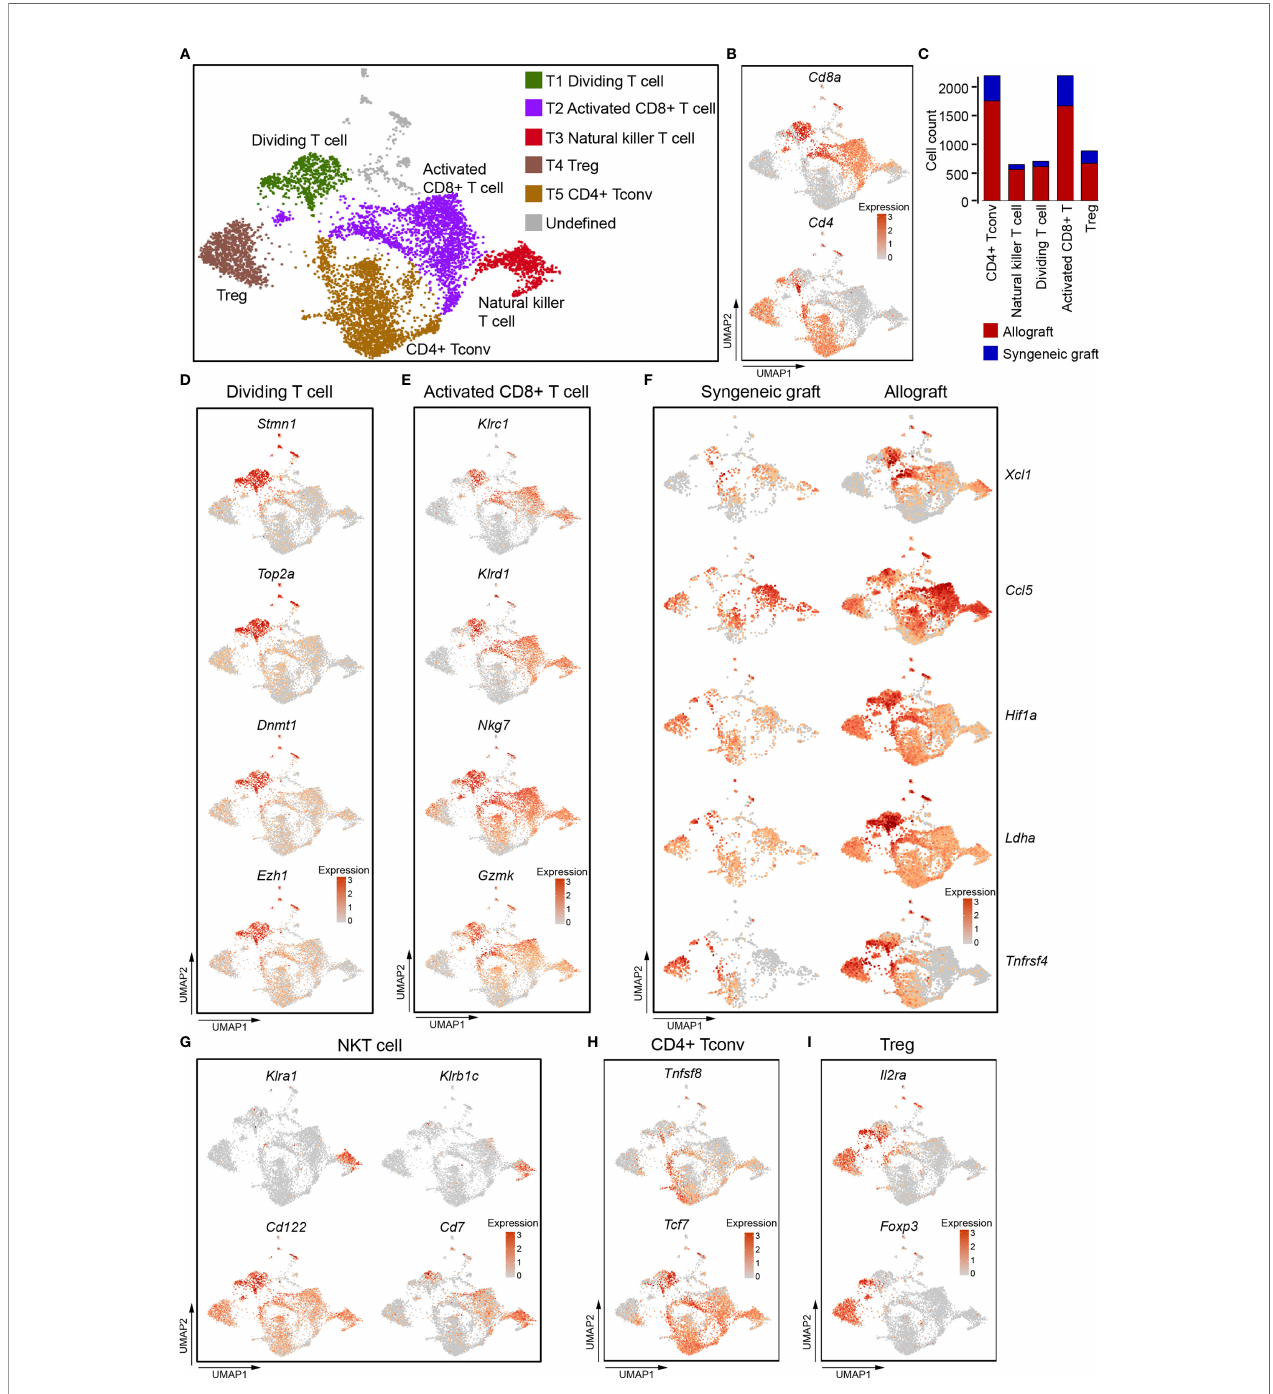
FIGURE 2 | Single-cell data revealed molecular details and subclusters of T cells. (A) UMAP visualization of the total T cells, with each cell colorcoded for the associated cell subtype. (B) UMAP visualization of the distribution of CD4 + T cells and CD8 + T cells by the expression of Cd4 and Cd8a . (C) The number of cells in the indicated cell type. (D) UMAP visualization shows the expression of Stmn1, Top2A, Dnmt1, Ezh2 for dividing/proliferating T cells. (E) UMAP visualization shows the expression of marker genes for activated CD8 + T cells. (F) UMAP visualization shows the increased expression of Xcl1, Ccl5, Hif1A, Ldha , and Tnfrsf4 in activated CD8 + T cells from allografts. (G – I) UMAP visualization of the expression of curated feature genes speci fi c for NKT cells (G) , CD4 Tconv (H) , and Treg (I) . Tconv, conventional T cell; Treg, regulatory T